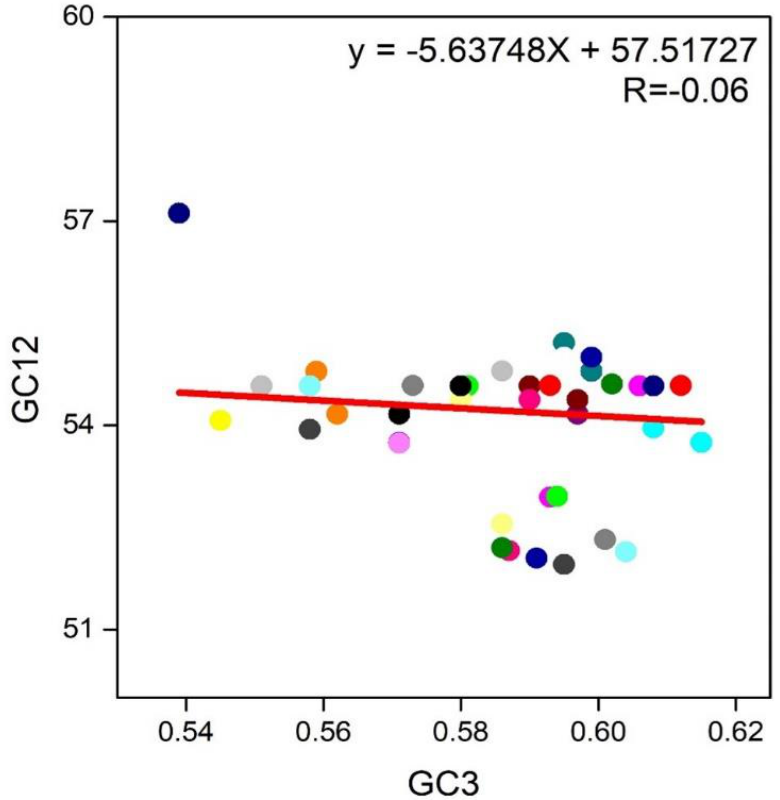
Figure 7. A Neutrality Plot between (GC3 vs. GC1,2) for the entire coding sequence of RYMV. GC1,2 represent GC at 1st and 2nd of the codon. While GC3 represents GC at 3rd codon position. And the Red solid represents the Regression analysis of GC1,2 against GC3.